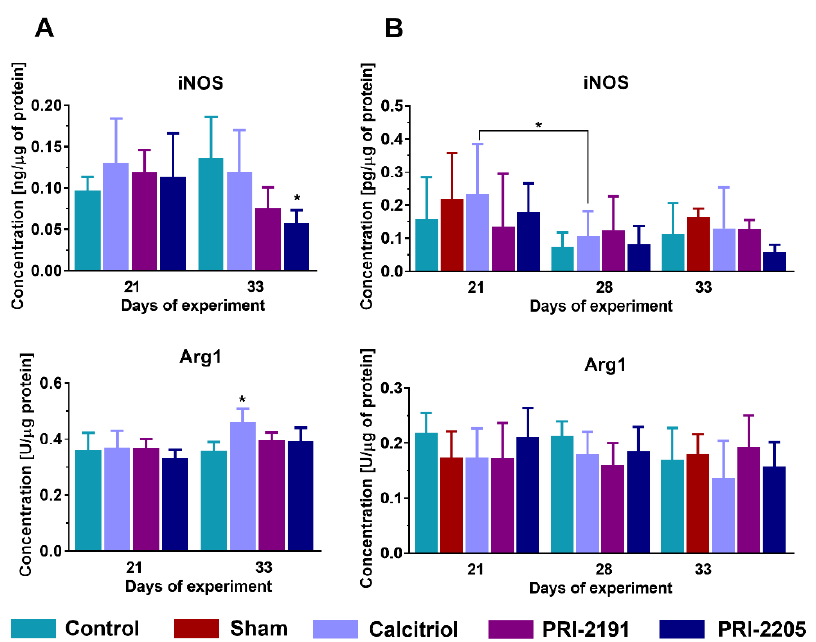
Figure 5. Changes related to protein expression in tumor tissue of 4T1 tumor-bearing ( A ) young and ( B ) aged OVX mice. Expression of selected proteins in tumor tissue measured using ELISA assays. The analysis was performed on samples harvested at days 14 and 28 (young mice) or days 21, 28, and 33 (aged OVX). Briefly, 60-week-old mice were subjected to ovariectomy or sham surgery. After 4 weeks, 4T1 cells were inoculated (day 0) orthotopically into aged OVX mice or 6–8-week-old young